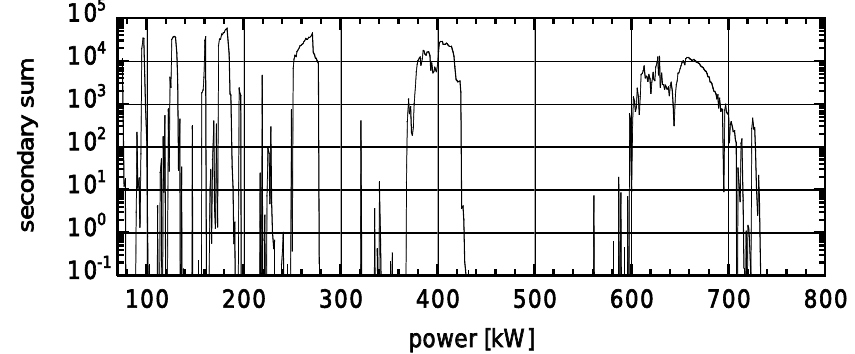
FIG. 1. Secondary multiplication summed over all launch phases in TESLA 40 mm, 50 V coax driven at 1.3 GHz with a maximum of 20 impacts from a single initial launch location on the outer conductor.